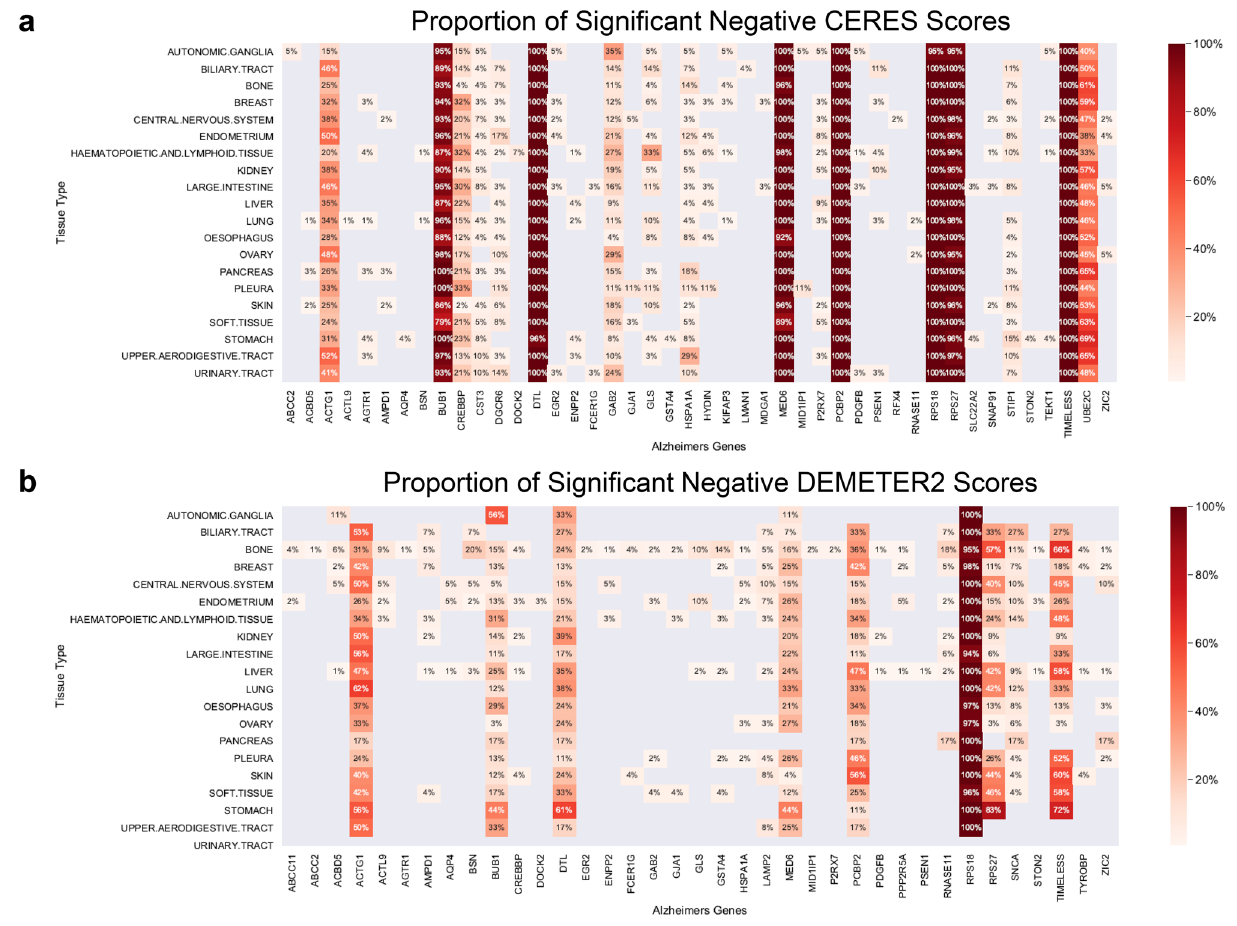
Figure 2. Genetic dependency of AD network hub genes in CRISPR knockout and knockdown screens across tissue lineages. ( a ) The proportion of pass-DepMap-threshold negative dependency scores (< − 0.5) in cell lines by tissue types based on the CERES scores derived from CRISPR knockout screens. ( b ) The proportion of pass- DepMap-threshold negative dependency scores (< − 0.5) in cell lines by tissue types based on the DEMETER2 scores derived from RNAi knockdown screens. For both ( a ) and ( b ), 20 tissue types from the Cancer Dependency Map (DepMap) project with data for at least 25 cell lines were utilized to evaluate 60 AD network hub genes. A negative dependency score indicates a gene’s necessity for a cell line’s growth and